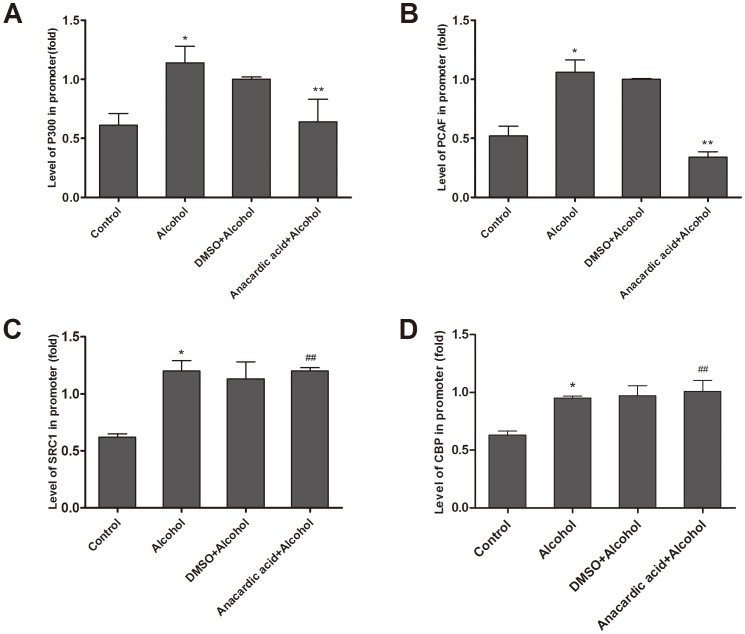
Anacardic acid inhibits the binding of HATs to the Gata4 promoter.Alcohol could improve binding of P300, PCAF, SRC1 and CBP to the Gata4 promoter on E14.5, and anacardic acid could repress binding of P300 and PCAF to the Gata4 promoter in cardiac tissues whereas anacardic acid could not decrease binding of SRC1 and CBP to the Gata4 promoter in the same cardiac tissues (A,B,C,D). *: P<0.01 vs. control group (n = 3), ##: P<0.05 vs. alcohol group (n = 3). **: P<0.01 vs. alcohol group (n = 3).